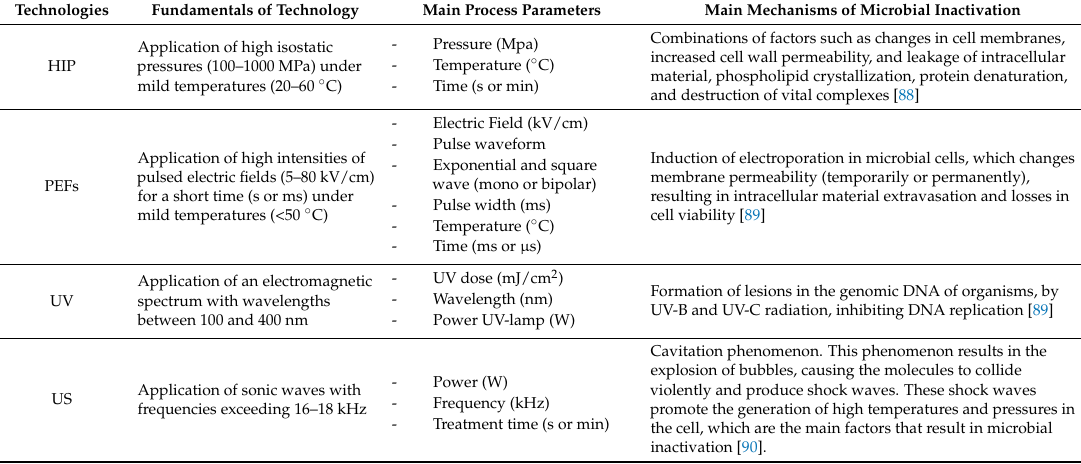
Table 2. The fundamentals, main process parameters, and mechanisms of microbial inactivation by emergence nonthermal processes. PEFs: Pulsed electric fields; US: